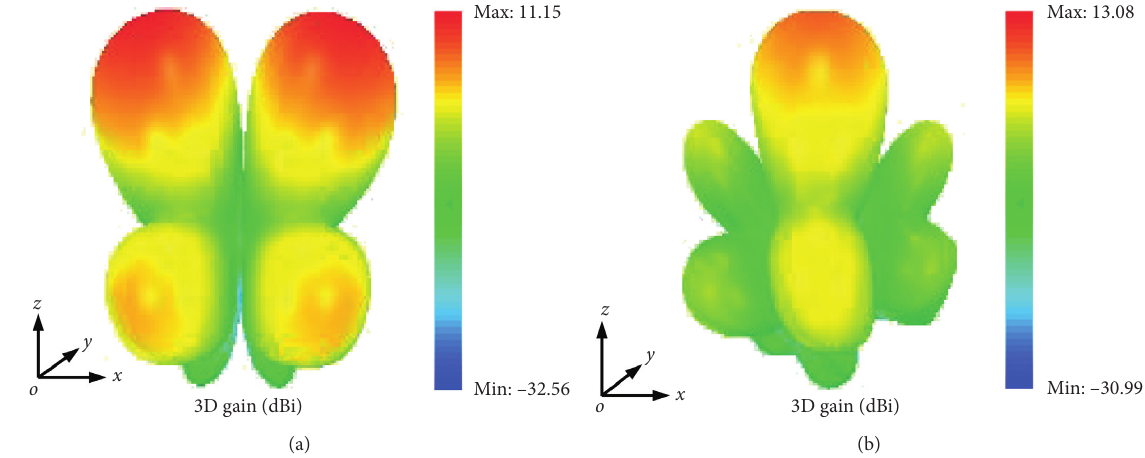
Figure 3: 3D gain of the reference antenna array. (a) Inverse balun. (b) Directional balun.